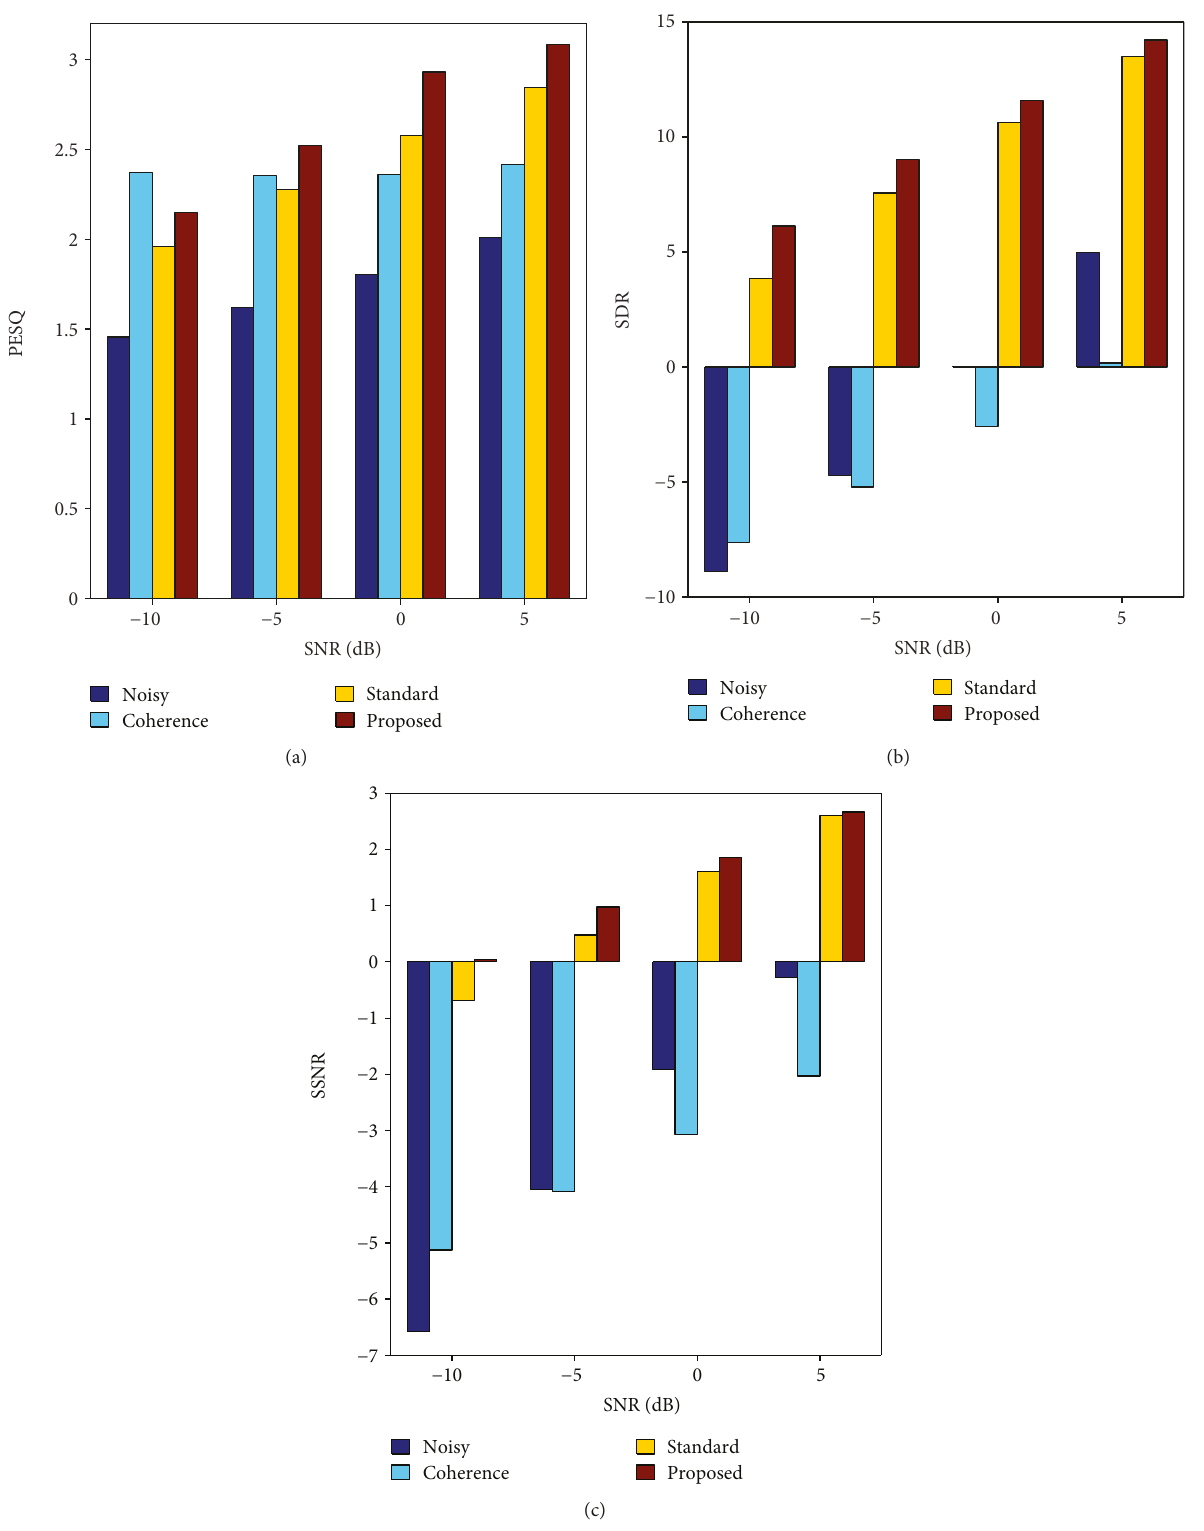
Figure 4: PESQ, SDR, and SSNR scores in Hfchannel noise